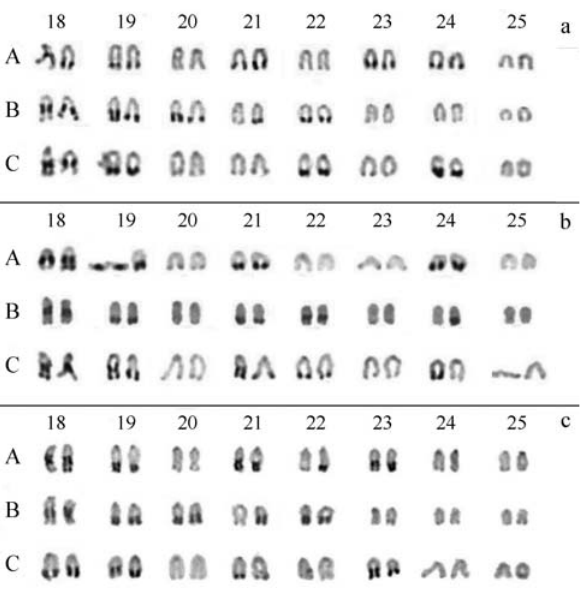
Figure2 -Interindividualvariationofheterochromaticblocksin Astyanax sp.D samples from the Bicudo (a) and Poço Claro (b) Rivers and from the nameless stream (c) from the left bank of the Iguaçu River basin. The let- ters at left represent some of the analyzed individuals. The numbers show the acrocentric chromosome pairs. Note that individual “B” of Poço Claro has an interstitial band on pair